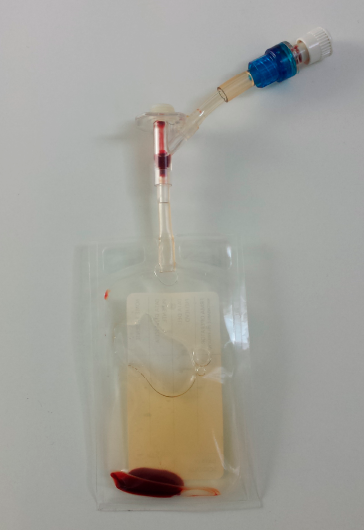
Figure 5. The pellet suspended in the platelet poor plasma (PPP) inside the storage bag.